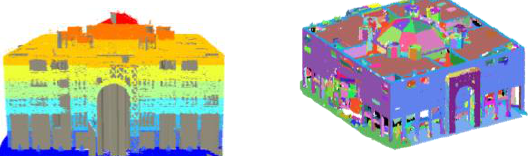
Figure 17. City Hall segmentation and façade detection Automatic façade detection is possible for buildings with less than 7 million points. See Figure 18.